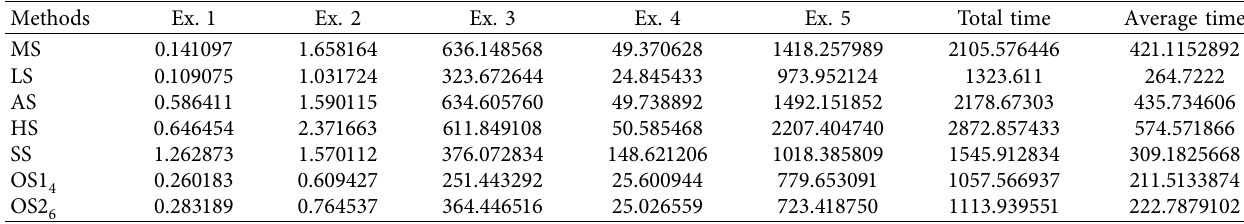
Table 6: CPU time taken by different methods on examples 1–5.